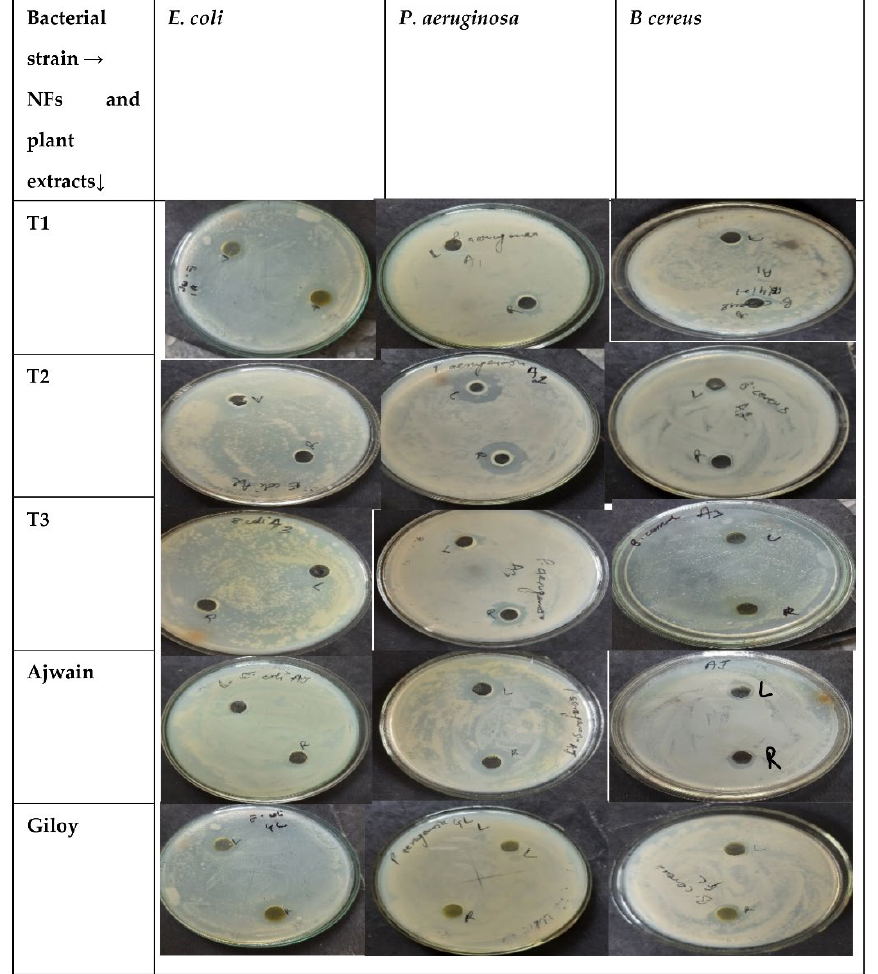
Figure 4. Antibacterial activity of NFs and extracts with the disc agar diffusion method. Table 1. Zone of inhibition (in mm) at different concentration of herbal extracts and their NFs. Zone of Inhibition (in mm) at Different Concentration of Herbal Extracts and Their NFs Bacterial Strains